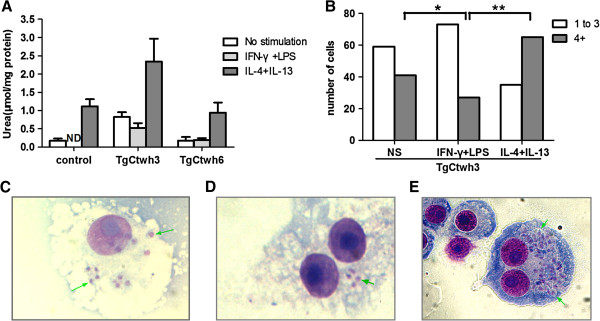
High arginase activity promoted parasite proliferation. (A) RAW264.7 cells were either pre-stimulated with 100 ng/ml IFN-γ and 100 ng/ml LPS, or 20 ng/ml IL-4 plus 5 ng/ml IL-13, or left unstimulated for 24 h, then left uninfected (white bars) or infected with TgCtwh3 (grey bars) or TgCtWh6 (black bars) for an additional 24 h (2:1 ratio of tachyzoites to cells), and assayed for arginase activity. (B) As in (A), the cells were stained with Wright-Giemsa at 24 h after infection and parasite replication was determined by counting the number of parasites from 100 parasitophorous vacuoles by microscopy. The bars depict the number of cells containing 1–3 parasites (white bars) or ≥4 parasites (dark bars) (Fisher’s exact test was used, *p<0.05, **p<0.01, IFN-γ plus LPS vs control or IL-4 plus IL-13). (C, D, and E) The proliferation of TgCtwh3 tachyzoites in RAW264.7 cells: unstimulated (C), pre-stimulated with IFN-γ plus LPS (D), and pre-stimulated with IL-4 and IL-13 (E). Arrow represents tachyzoites. NS: no stimulation.